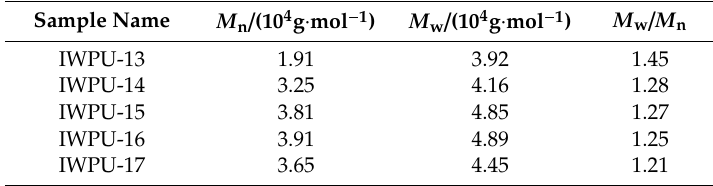
Table 4. GPC results of